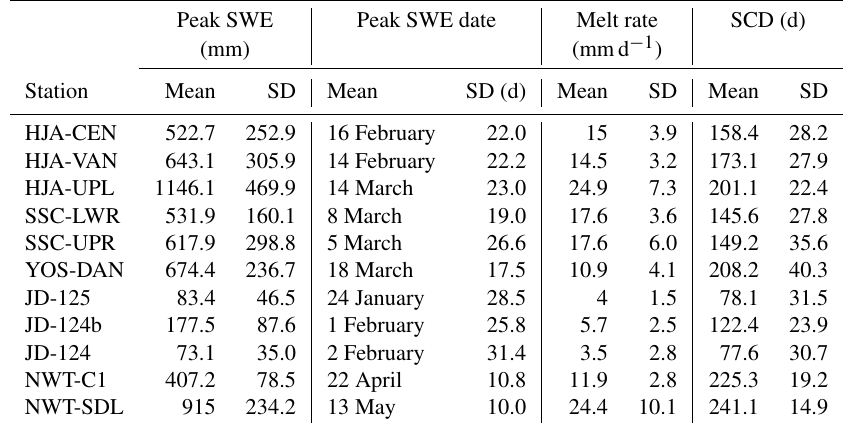
Table 3. Mean snow cover evolution metrics for the 11 stations. Each mean and standard deviation was calculated across all water years and all precipitation phase methods.